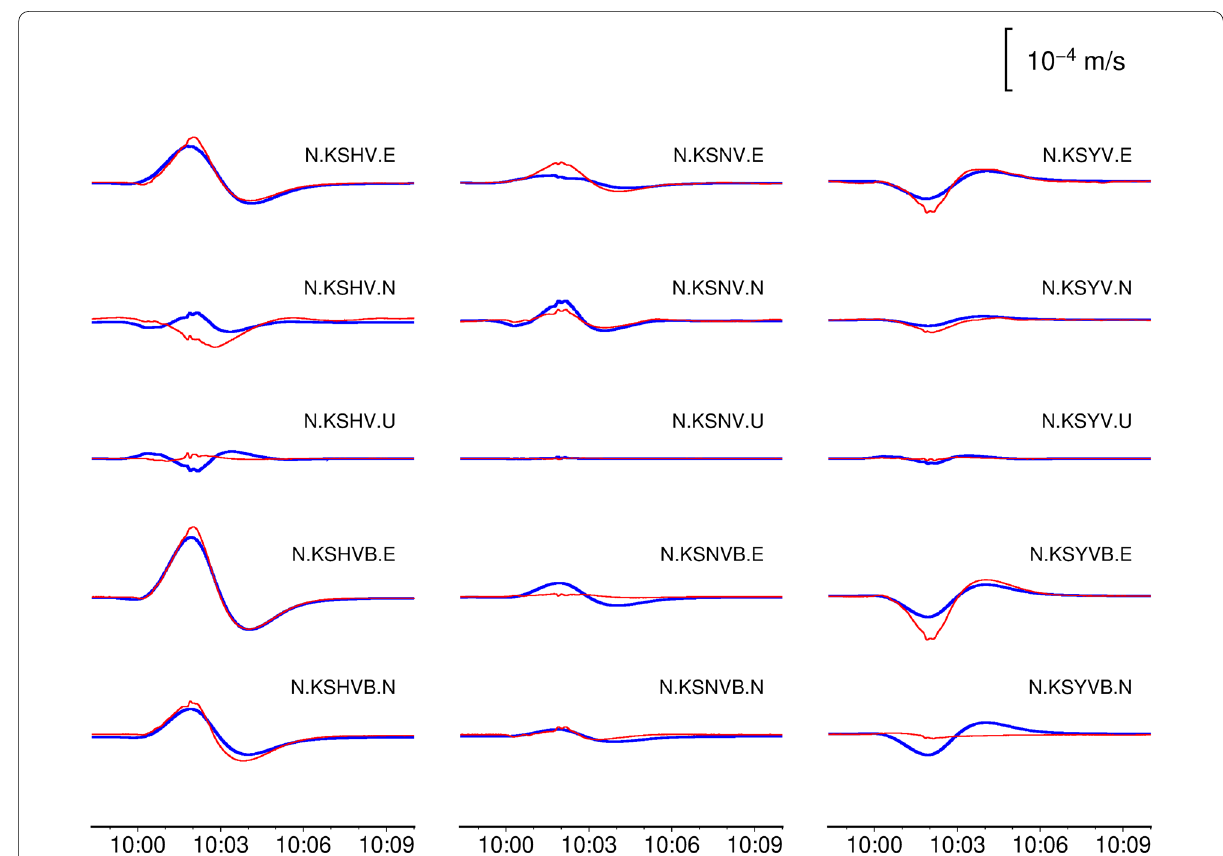
Fig. 16 Waveform fitting between the observed (red) and synthetic (blue) waveforms for candidate ( g1 ). The waveforms at N.KSHVB, N.KSNVB, and N.KSYVB represent the tilt records converted to velocity responses